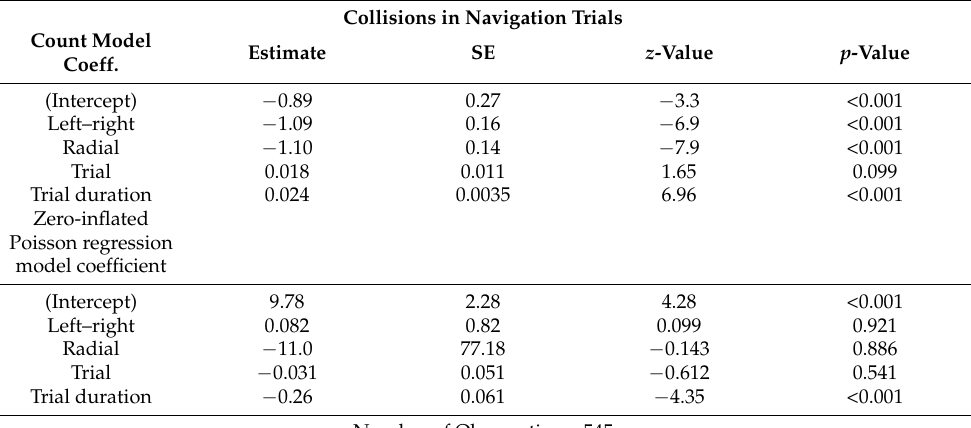
Table A2. Results of the analysis of collisions in navigation trials. The applied model was a zero- inflated Poisson regression model.